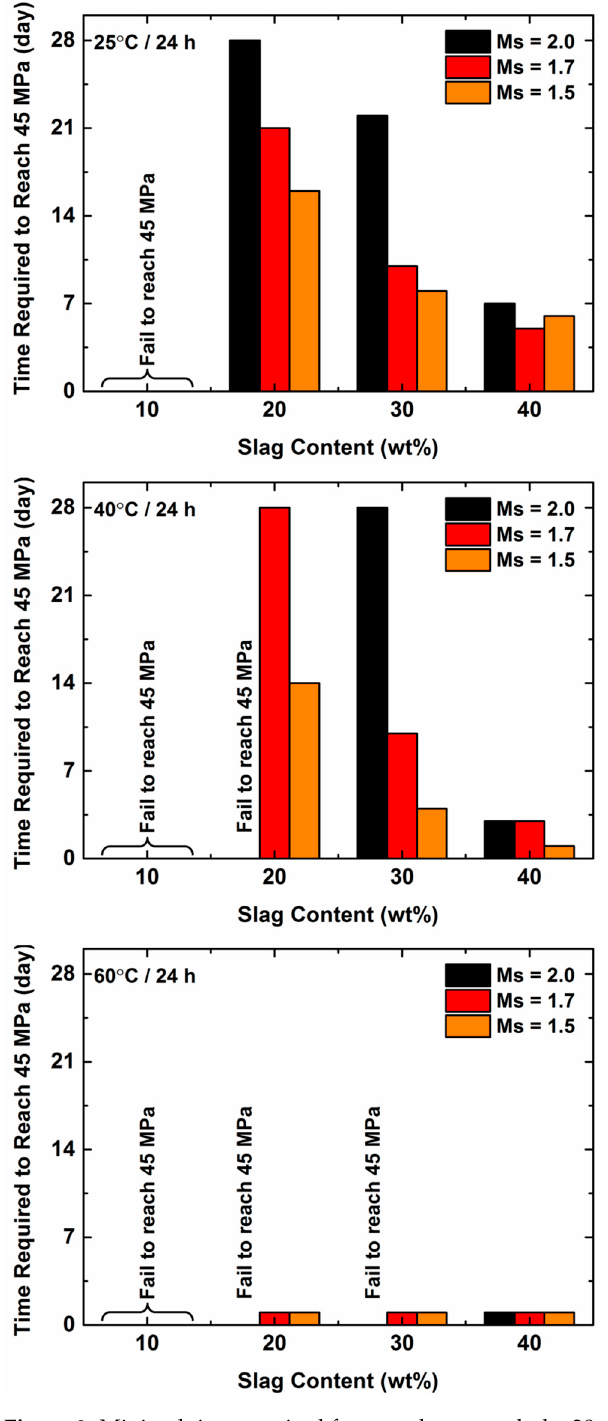
Figure 3. Minimal time required for samples to reach the 28-day compressive strength requirement of AS 3972 [47].